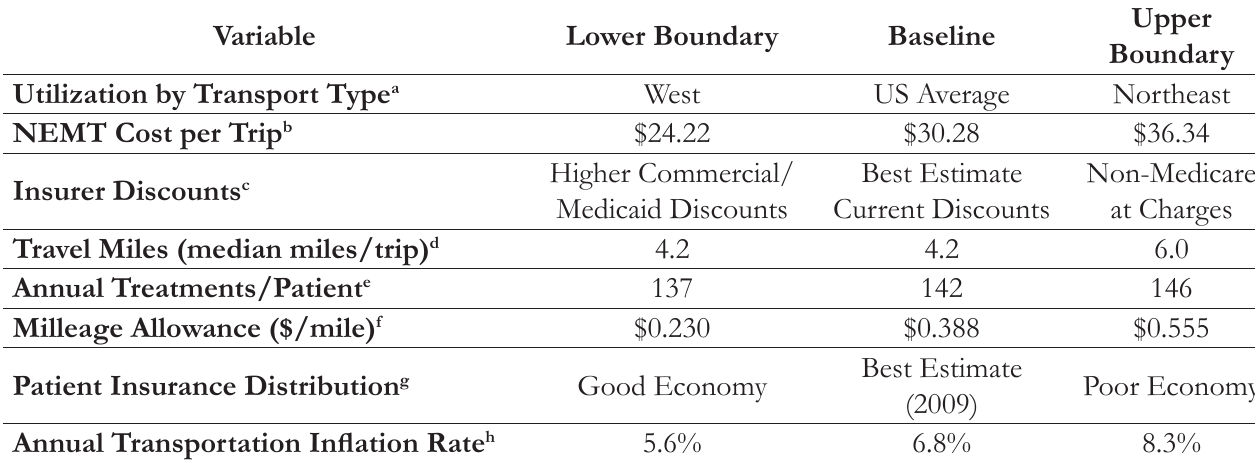
Table 3. Sensitivity Analysis: Plausible Ranges of Values, Sources and